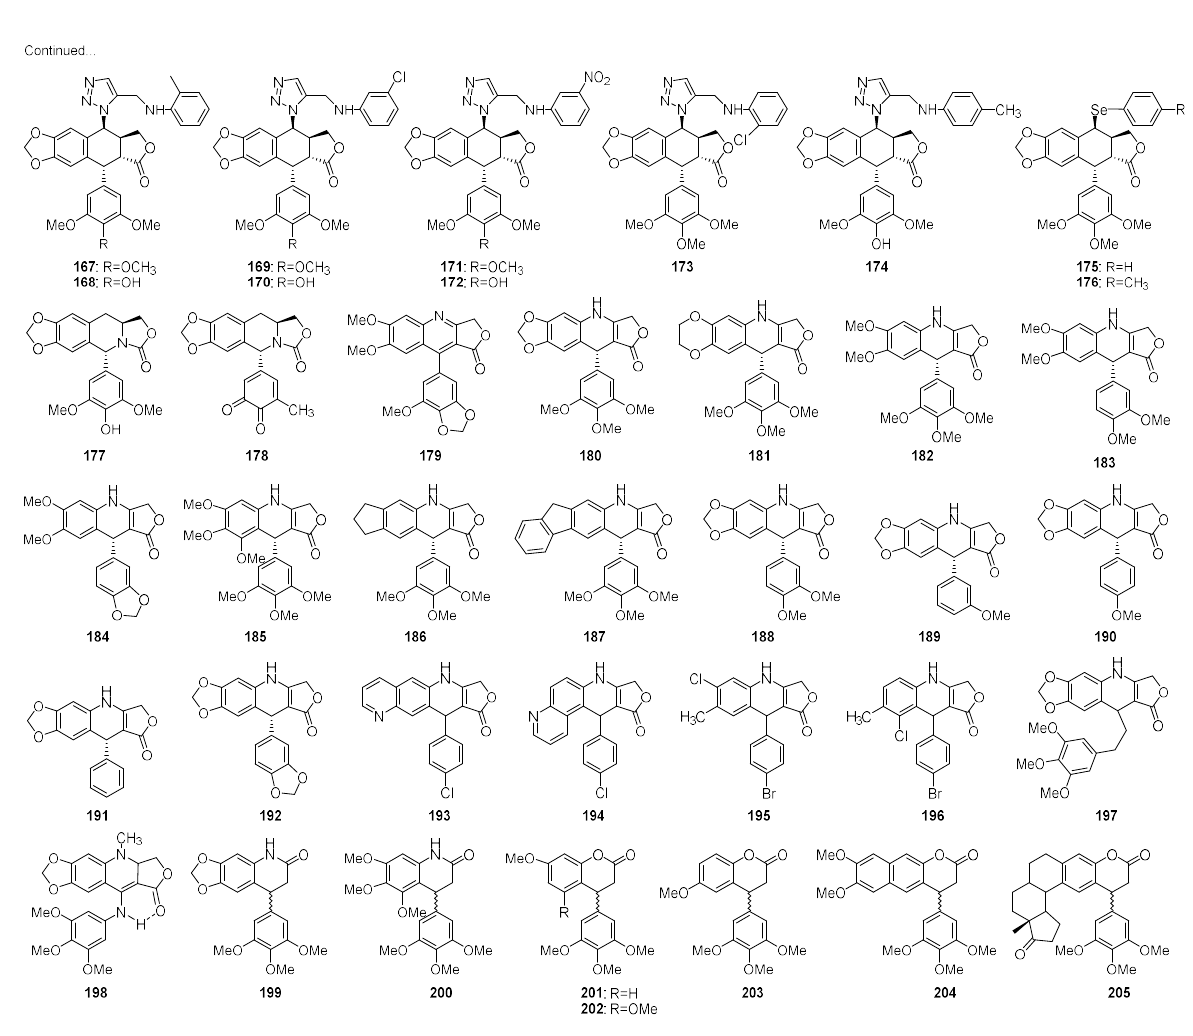
Figure 6. C-ring modified